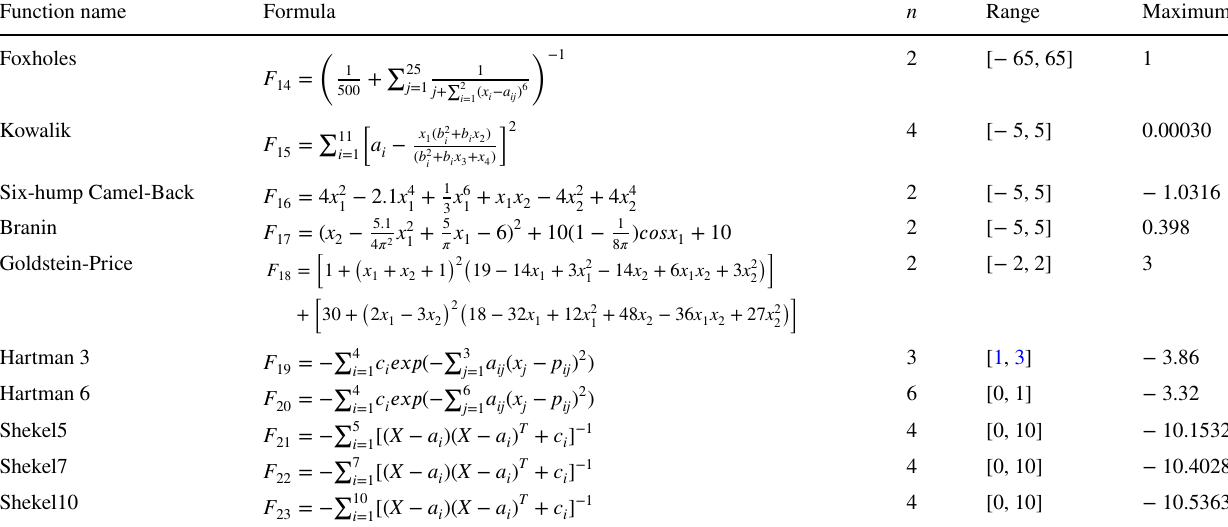
Table 3 Multimodal benchmark functions with fixed dimension Function